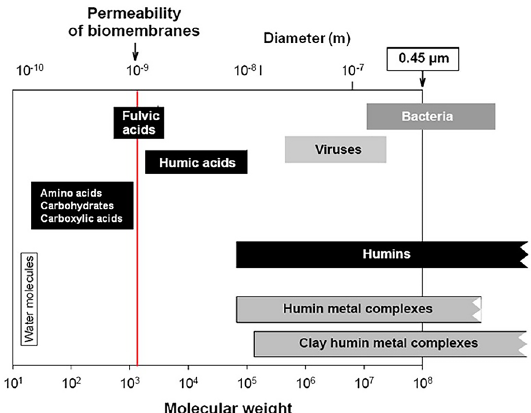
Fig. 2 Size fractions of different types of organic carbon. Modified by Vetter (2012) after Thurman